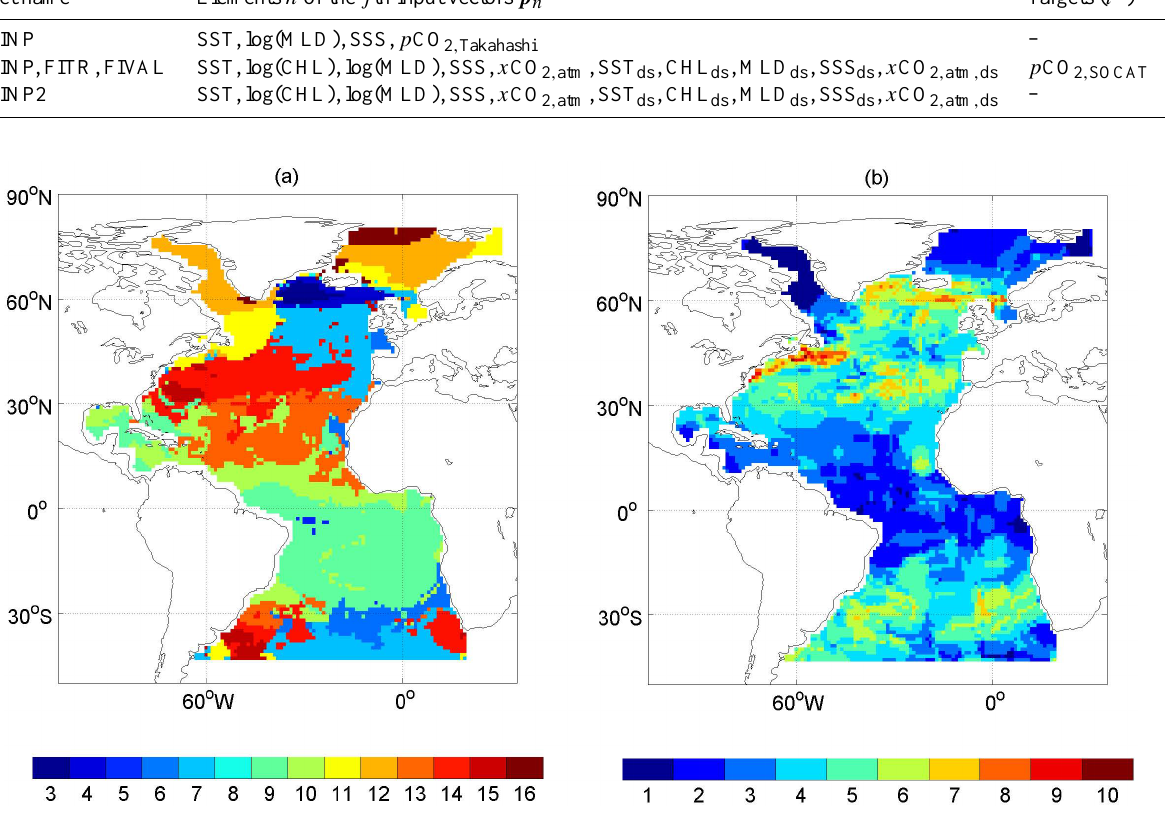
Fig. 1. Map of the biogeochemical provinces in the Atlantic Ocean identified by the self-organizing map (SOM) method: (a) province number of the mode (i.e. most frequent occurrence). Provinces 1 and 2 do not occur in the Atlantic Ocean. (b) The number of different provinces every pixel belongs to for each month from January 1998 to December